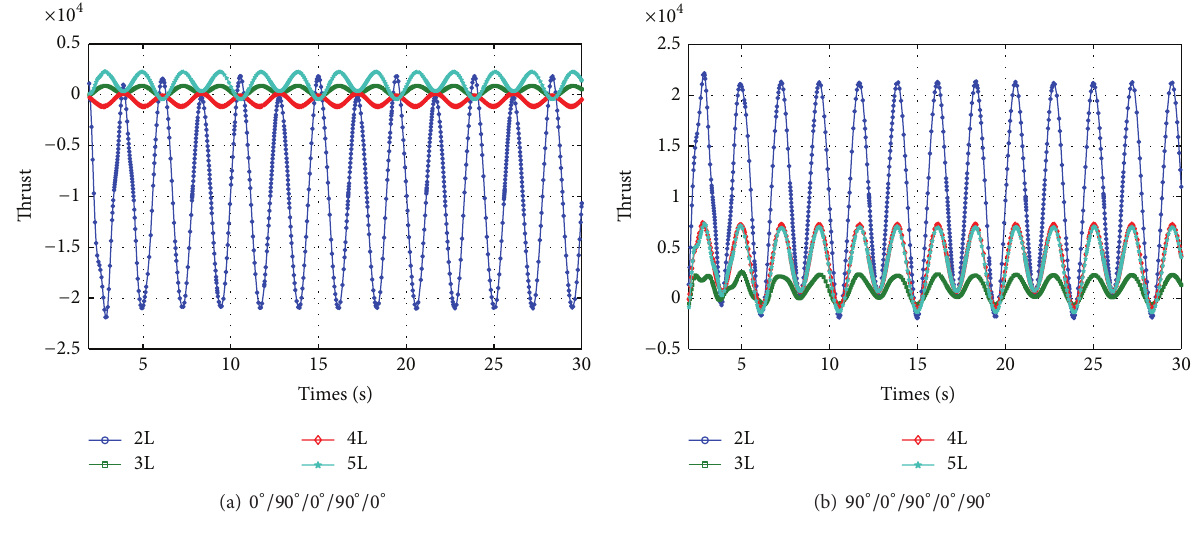
Figure 7: Thrust of fin in the case of rotation motion.